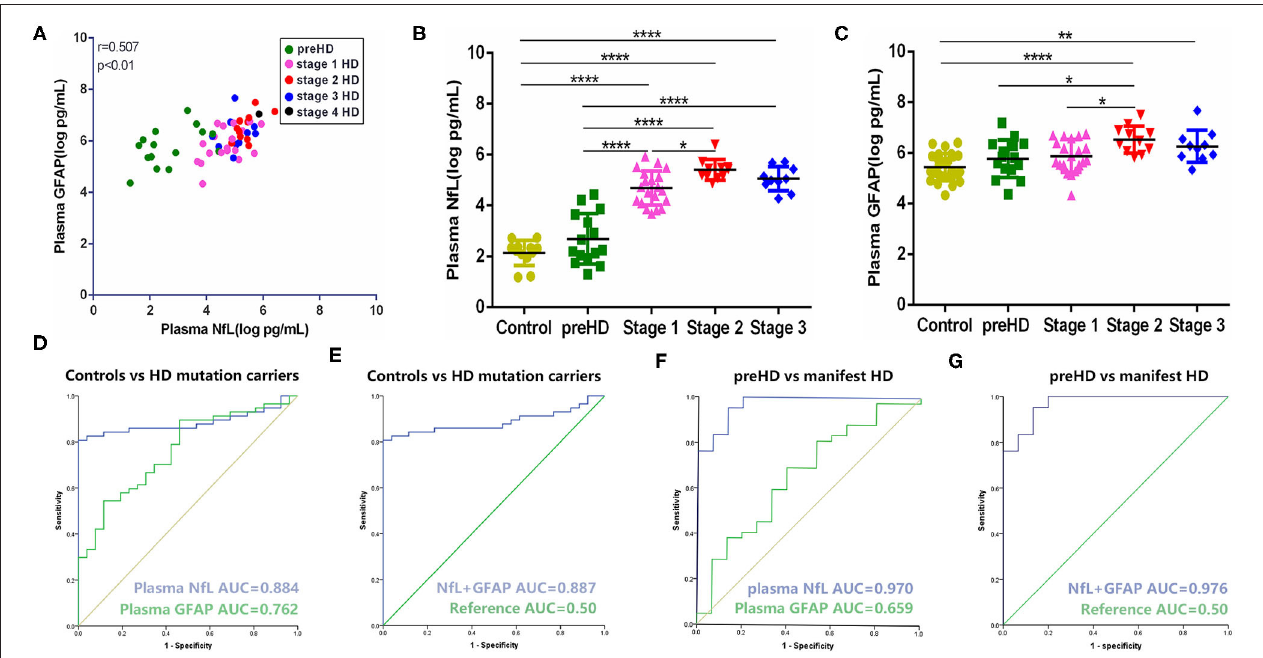
FIGURE 1 | Comparison and correlation of plasma NfL and GFAP. (A) Correlation of plasma NfL and GFAP in HD mutation carriers ( n = 57). (B) Concentration of plasma NfL across disease stages (controls: n = 26; preHD: n = 15; stage 1: n = 20; stage 2: n = 11; stage 3: n = 10). (C) Concentration of plasma GFAP across disease stages (controls: n = 26; preHD: n = 15; stage 1: n = 20; stage 2: n = 11 stage 3: n = 10). (D) ROC curves for discrimination between controls ( n = 26) and HD mutation carriers ( n = 57) [95% confidence intervals (CIs) for AUCs: plasma NfL, 0.810–0.958, p < 0.0001; plasma GFAP, 0.657–0.868, p < 0.0001]. (E) ROC curves for discrimination between controls ( n = 26) and HD mutation carriers ( n = 57) with combination of plasma NfL and GFAP (95% CIs for AUCs: 0.814–0.960, p < 0.0001). (F) ROC curves for discrimination between preHD ( n = 15) and manifest HD participants ( n = 42) (95% CIs for AUCs: plasma NfL, 0.929–1.000, p < 0.0001; plasma GFAP, 0.496–0.822, p = 0.070). (G) ROC curves for discrimination between preHD ( n = 15) and manifest HD participants ( n = 42) with combination of plasma NfL and GFAP (95% CIs for AUCs: 0.934–1.000, p < 0.0001). Significance level was defined as p < 0.05. * p < 0.05, ** p < 0.01, and **** p < 0.0001.